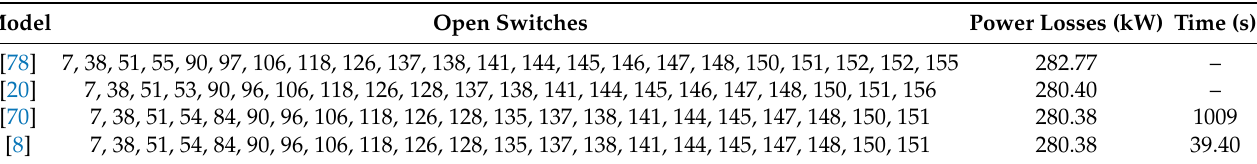
Table 15. Comparative analysis of the 136-bus test